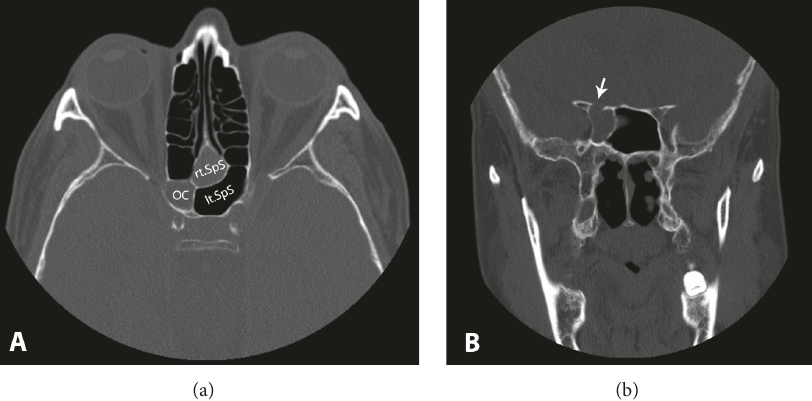
Figure 2: Computerized tomography of paranasal sinus. (a) Anatomical location of Onodi cell (OC); right (rt.SpS) and left sphenoid sinus (lt.SpS). (b) Open roof of superior wall of right sphenoid sinus (white